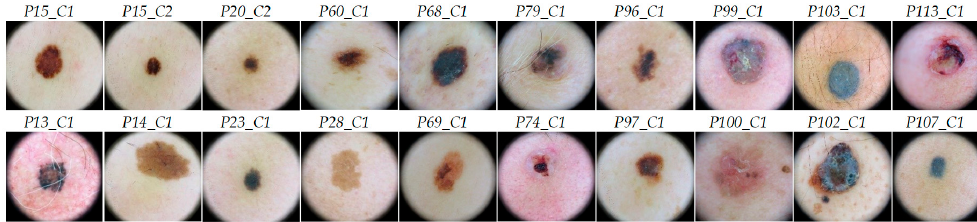
Figure 3. RGB images obtained with the digital dermoscopic camera with their correspondent image ID above. The first row shows the validation set images and the second row the test set images